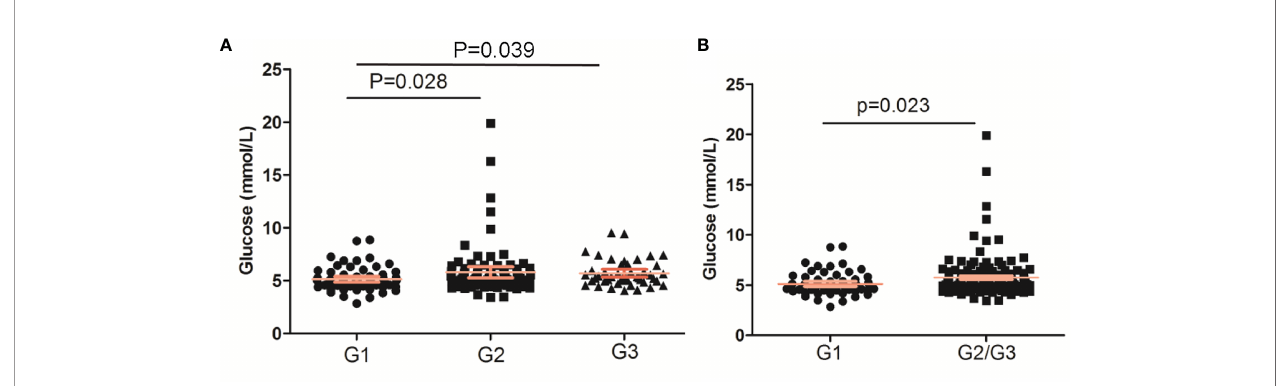
FIGURE 1 | The glucose levels based on WHO grade of pancreatic neuroendocrine neoplasms. (A) PNENs were divided into three groups; (B) PNENs were divided into two groups.